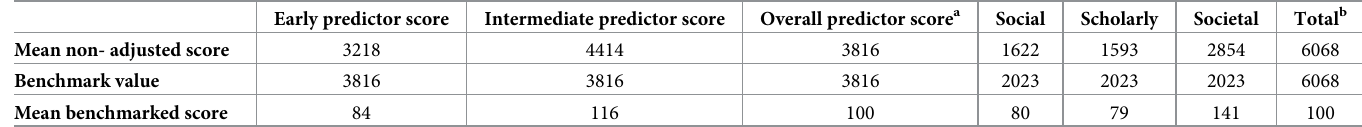
Table 4. Scores in the benchmark sample before and after benchmark adjustment. Non-adjusted scores chosen as benchmarks are shown in bold.